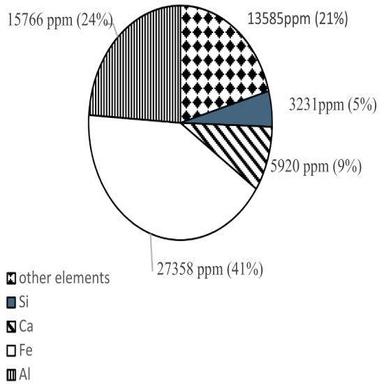
ICP plasma spectroscopy data concentrations of Clay sample.